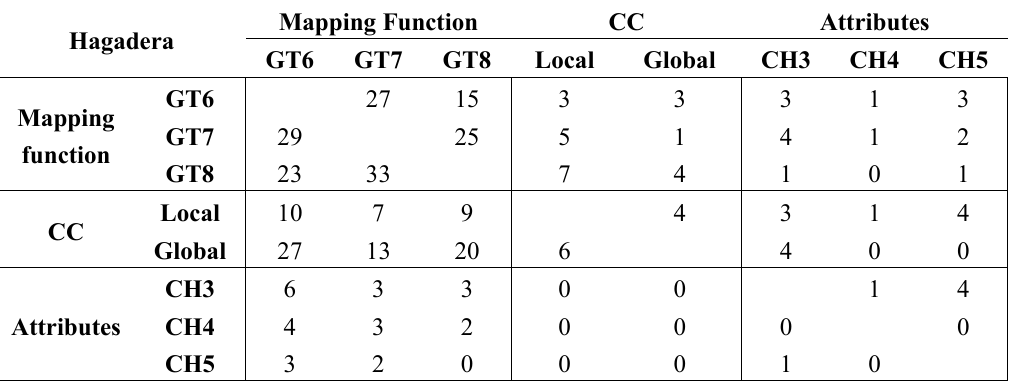
Table 6. Interdependency test of the method constituents for the Hagadera